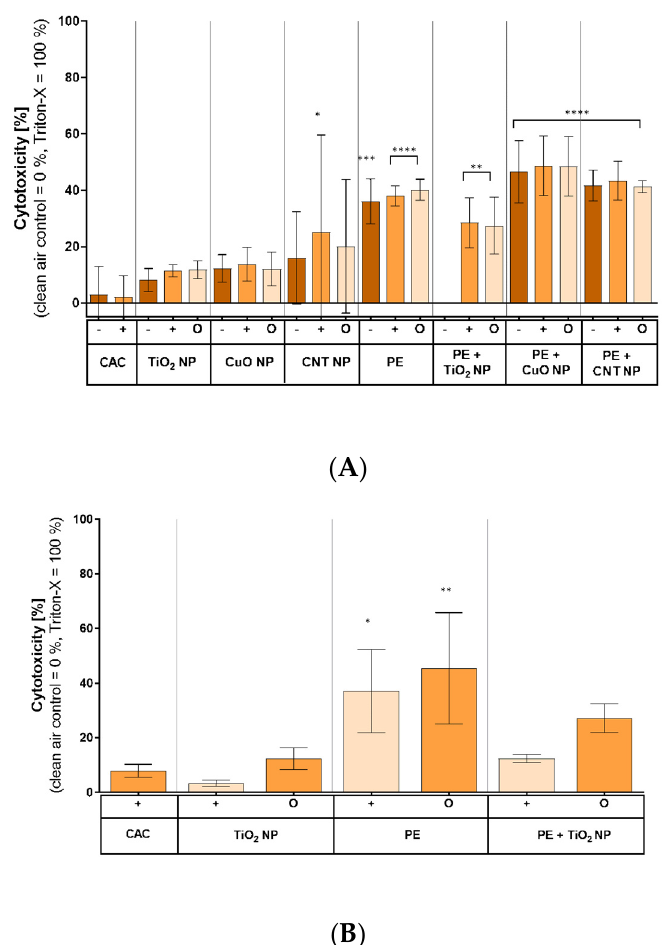
Figure 5. LDH release of A549 cells ( A ) and MucilAir™ tissue ( B ) after exposure to combustion- generated aerosols. Both cell systems were exposed to aerosols under conditions of normal particle deposition ( − ), increased particle deposition (+), and a filtered aerosol without particle fraction (O) for 4 h, as previously described, and incubated for 20 h. The 0.1% Triton X-100 incubated for 10 min was used as positive control for total cell lysis. Shown are the mean values of at least three independent experiments ( n = 3) ± standard deviation (SD). Statistically significant by using one-way analysis of variance (ANOVA) followed by post hoc Dunnett's test; * p ≤ 0.05; ** p ≤ 0.01; *** p ≤ 0.005; **** p ≤ 0.001. -: normal aerosol exposure; +: exposure under enhanced particle deposition; O: exposure of a filtered aerosol.